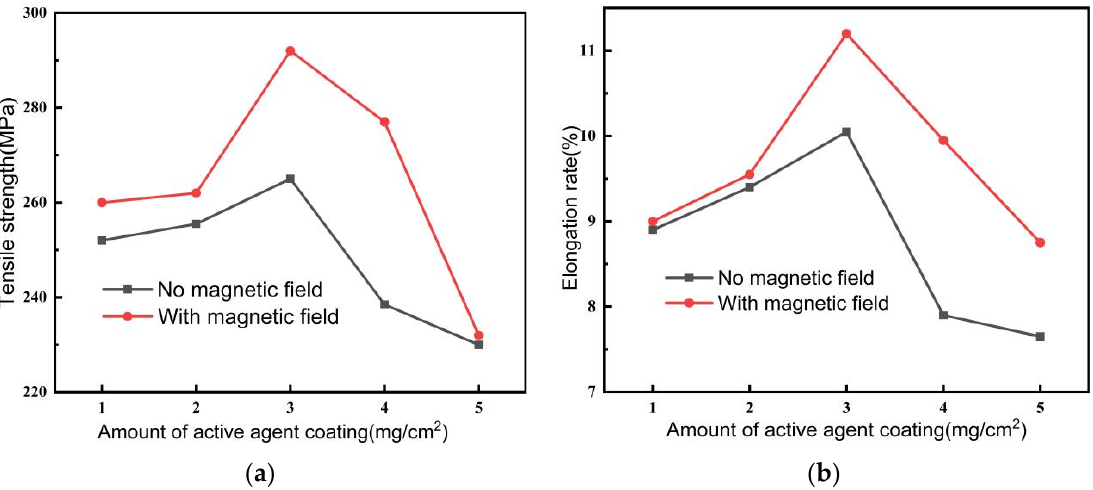
Figure 5. The tensile strength ( a ) and elongation ( b ) of the welded samples as a function of coating quantities welded without and with a magnetic field.